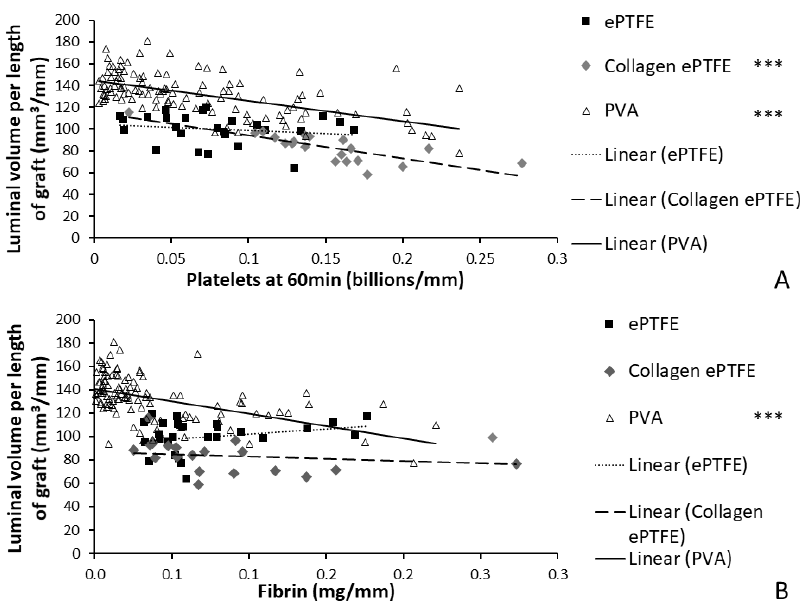
Figure 8. Validation of Amira quantification by correlation of luminal cross-sectional area with ( A ) platelet accumulation and ( B ) fibrin accumulation. *** indicates p < 0.001.